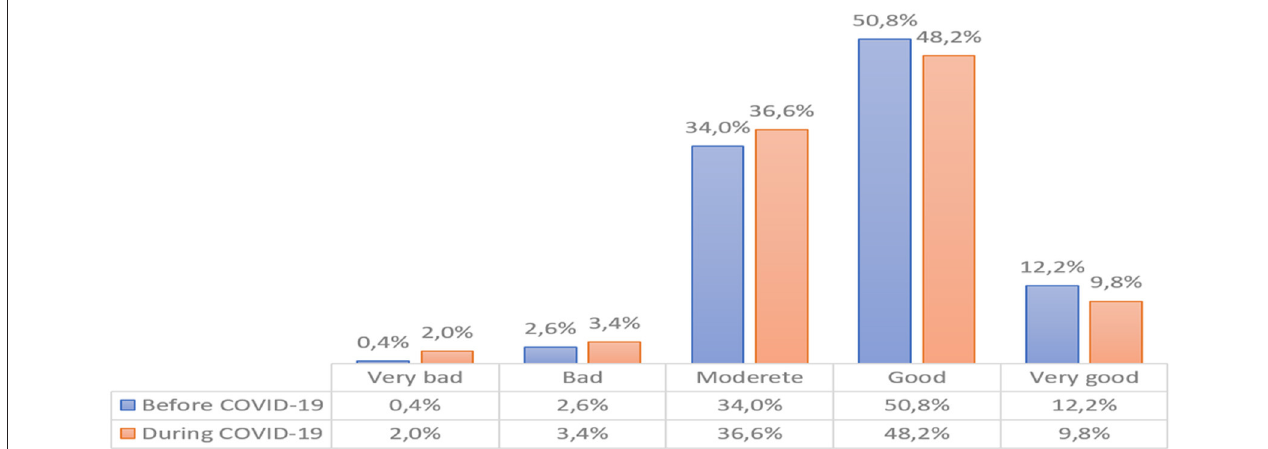
FIGURE 1 | A summary evaluation of the quality of life in the study group (according to WHOQOL)— N = 450.